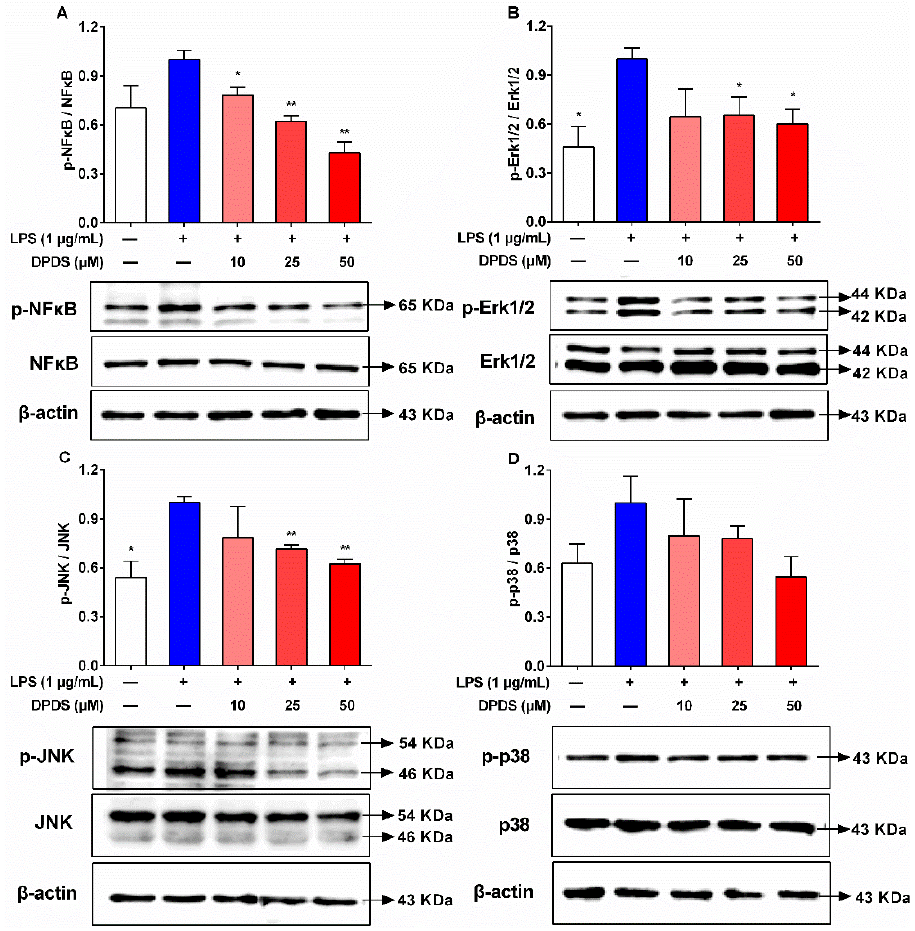
Figure 6. DPDS suppressed LPS-induced NF κ B and MAPK signaling in HBZY-1 cells. HZBY-1 cells were exposed to LPS (1 µ g/mL) alone or in combination with DPDS (10, 25 or 50 µ M) for 24 h. ( A ) The protein bands of p-NF κ B, NF κ B and the ratios of p-NF κ B/NF κ B. ( B ) The protein bands of p-ERK1/2/, ERK1/2 and the ratios of p-ERK1/2/ERK1/2. ( C ) The protein bands of p-JNK, JNK and the ratios of p-JNK/JNK. ( D ) The protein bands of p-p38, p38 and the ratios of p-p38/p38. Values are presented as fold of the LPS group and as means ± SEM, n = 3. * p < 0.05, ** p < 0.01 versus the LPS group.